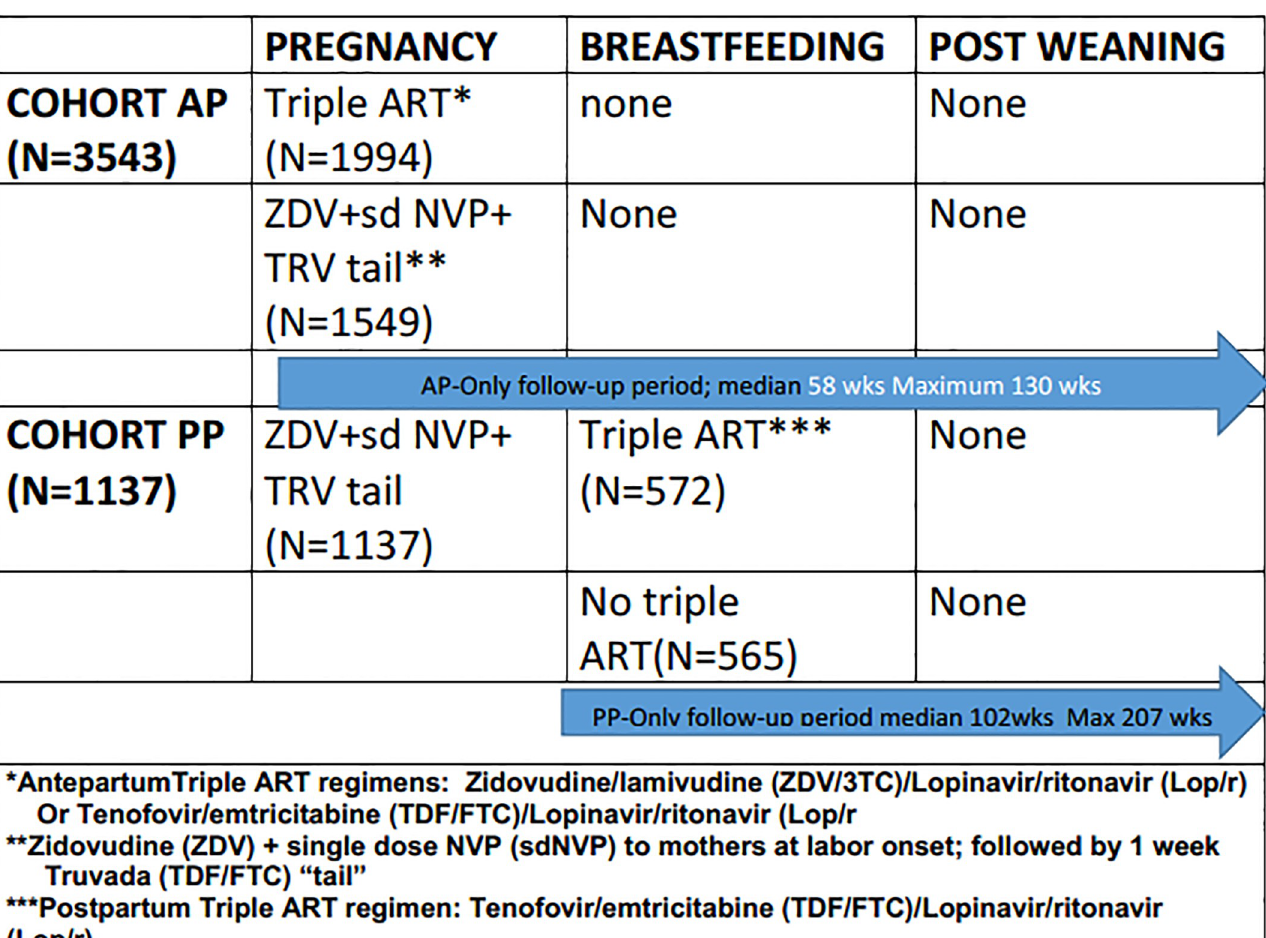
Fig 1. 1077BF/1077FF follow up and study comparison groups for AP-only and PP-only